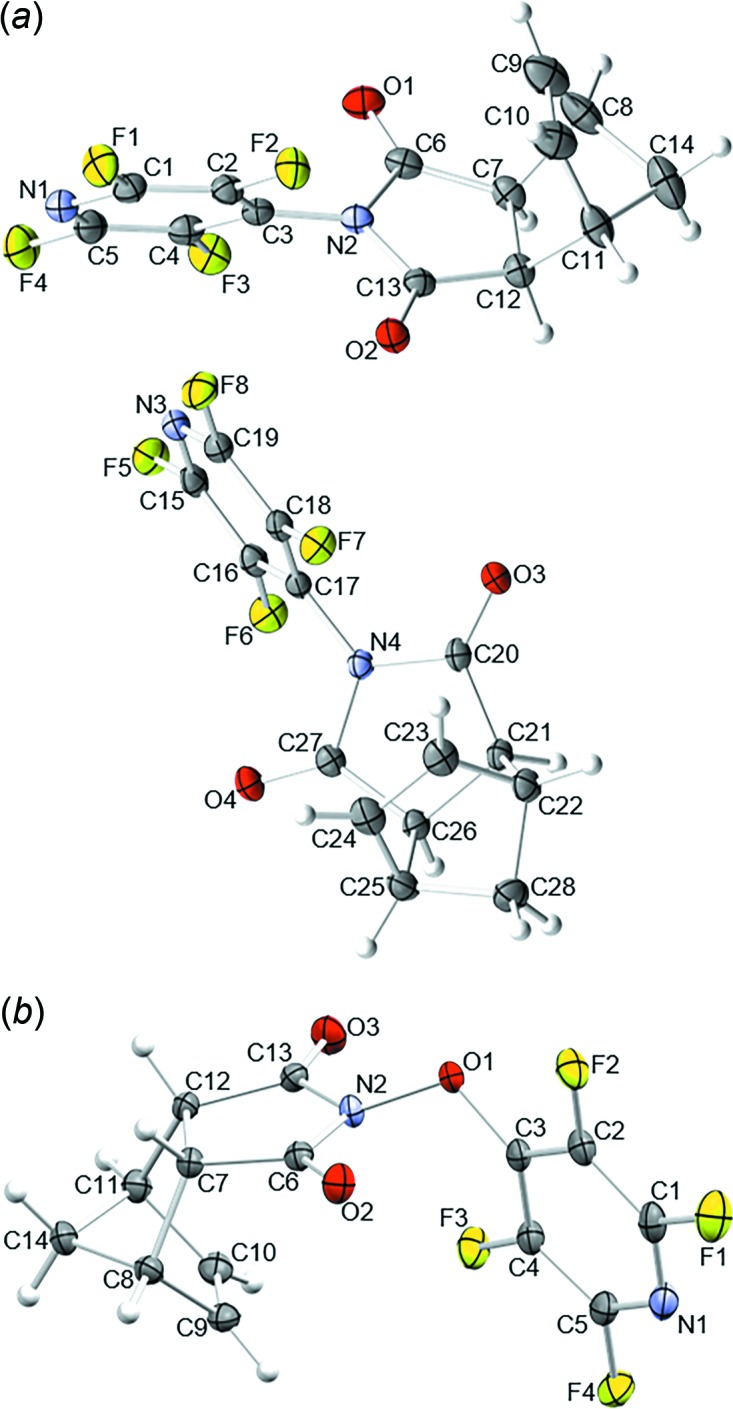
The mol­ecular structures of (a) I and (b) II. Displacement ellipsoids are shown at the 50% probability level.